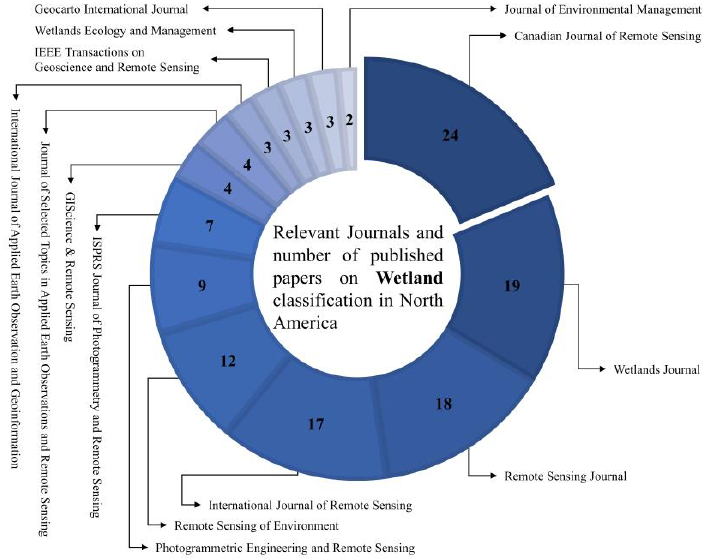
Figure 10. Number of wetland classification papers published per journal (only those journals that have published 2 or greater papers are included).